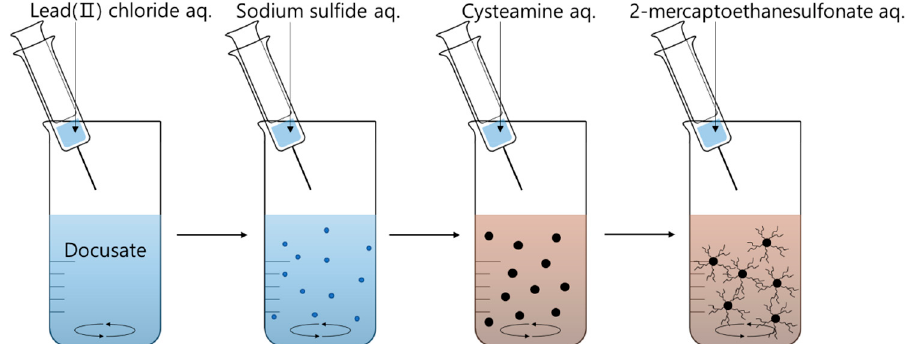
Figure 1. A brief description of synthesis of aggregation - free PbS quantum dots. At the first step, lead chloride aqueous solution was added into double distilled water containing docusate sodium as a stabilizing agent. A sodium sulfide aqueous solution was injected to the solution to cause formation of PbS quantum dot. For ligand exchange, cysteamine aqueous solution was dropped into the colloid of PbS quantum dot, and subsequently 2-mercaptoethanesulfonate aqueous solution was added into the solution for preventing the aggregation of cysteamine.